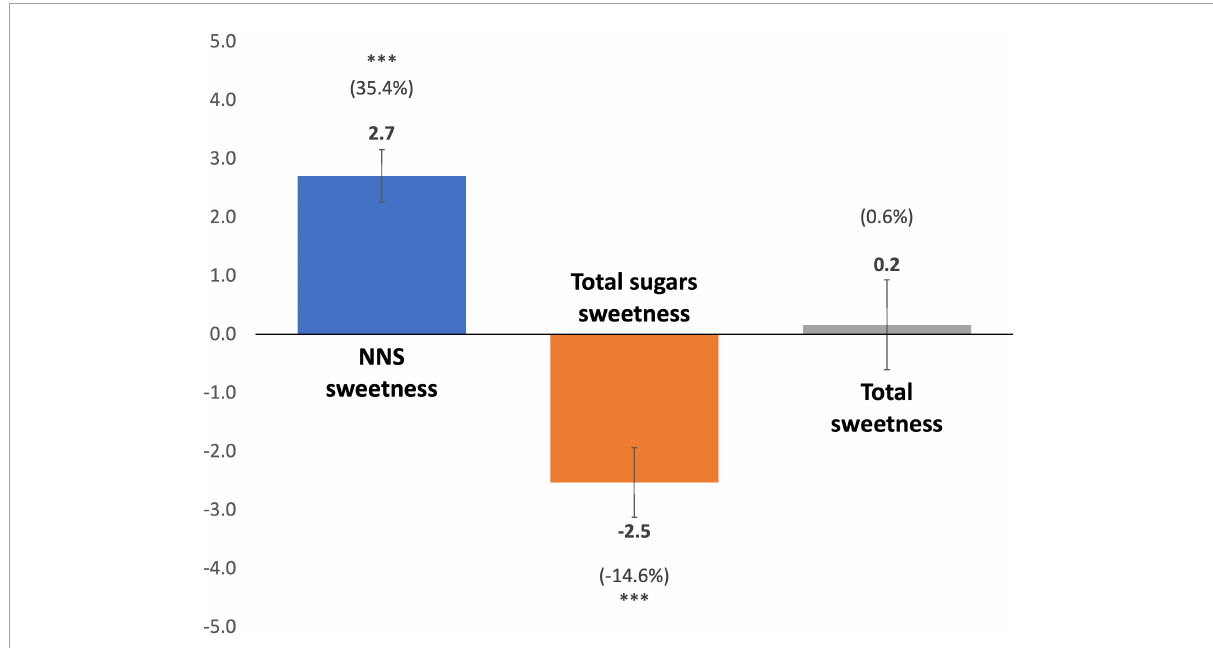
FIGURE1 Mean differences in sweetness between estimated adjusted post-policy purchases and estimated adjusted counterfactual post-policy purchases. Estimates are derived from fixed-effects models comparing post-policy sweetness of purchases to counterfactual post-policy sweetness of purchases based on pre-policy trends for each sweetness index. Purchase data provided by Kantar WorldPanel Chile. Error bars indicate 95% confidence intervals. NNS, Non-nutritive sweetener. *** P -value <